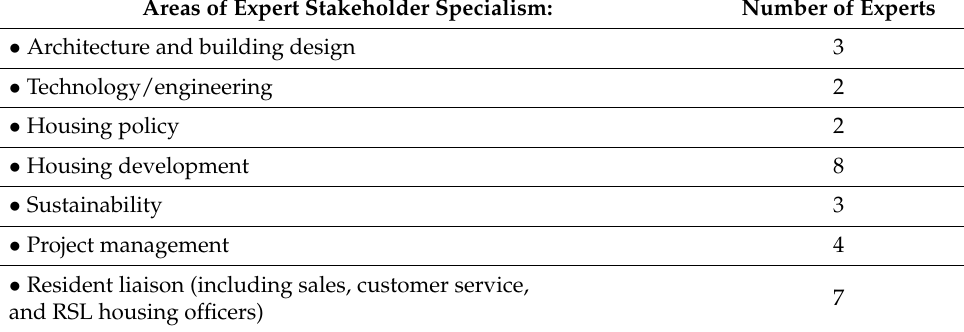
Table 2. Experts. Areas of Expert Stakeholder